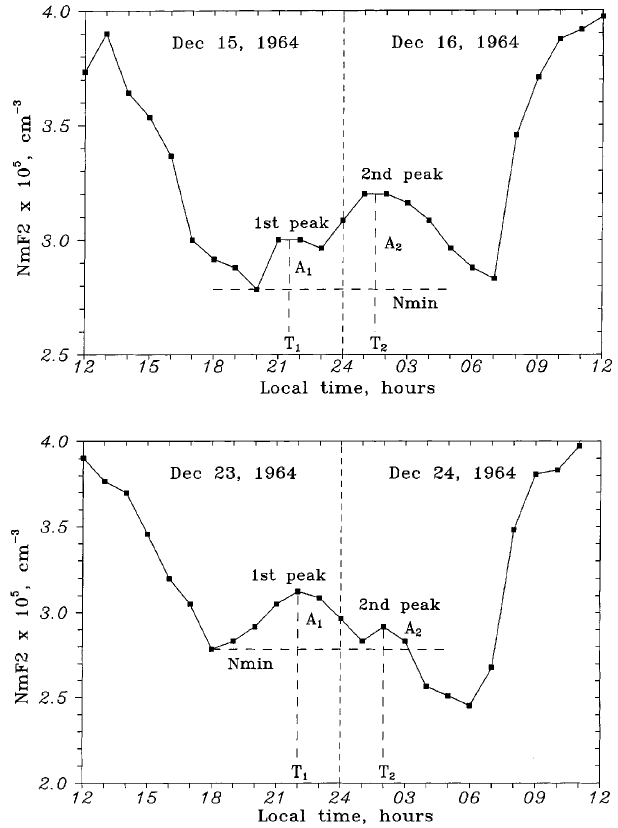
Fig. 1. Two peaks and N NmF2